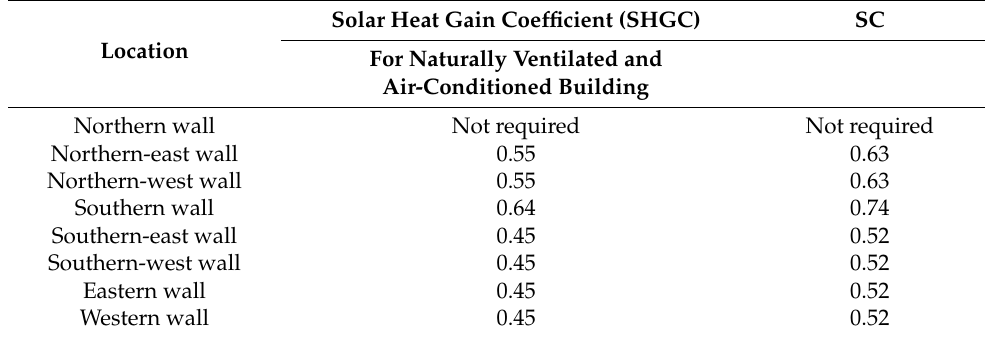
Table A2. The maximum value allowed for solar heat gain coefficient (SHGC) for Cairo climate with the window wall ratio (WWR) 10–20%